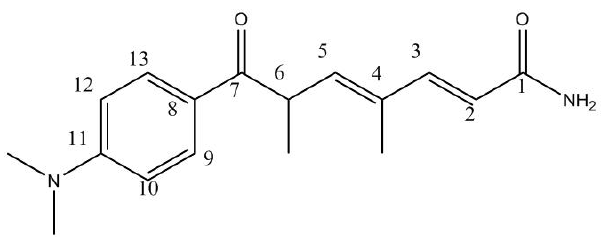
Figure 1. The chemical structure of